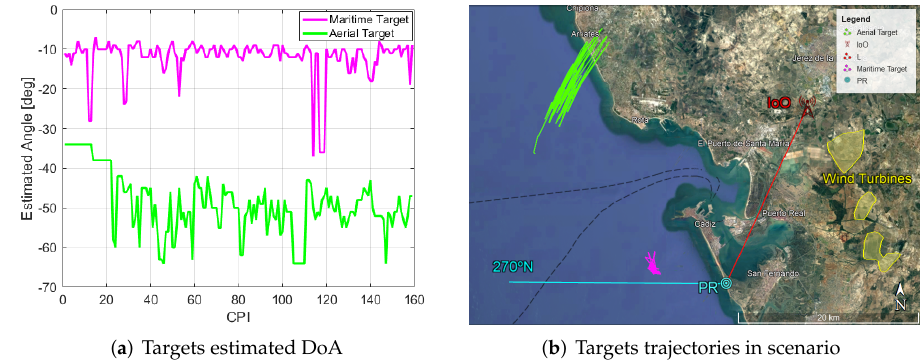
Figure 16. Estimated angle of each target along CPI and transformation of characteristics extracted from the radar data (range, angle) from them to Google Earth in the trials